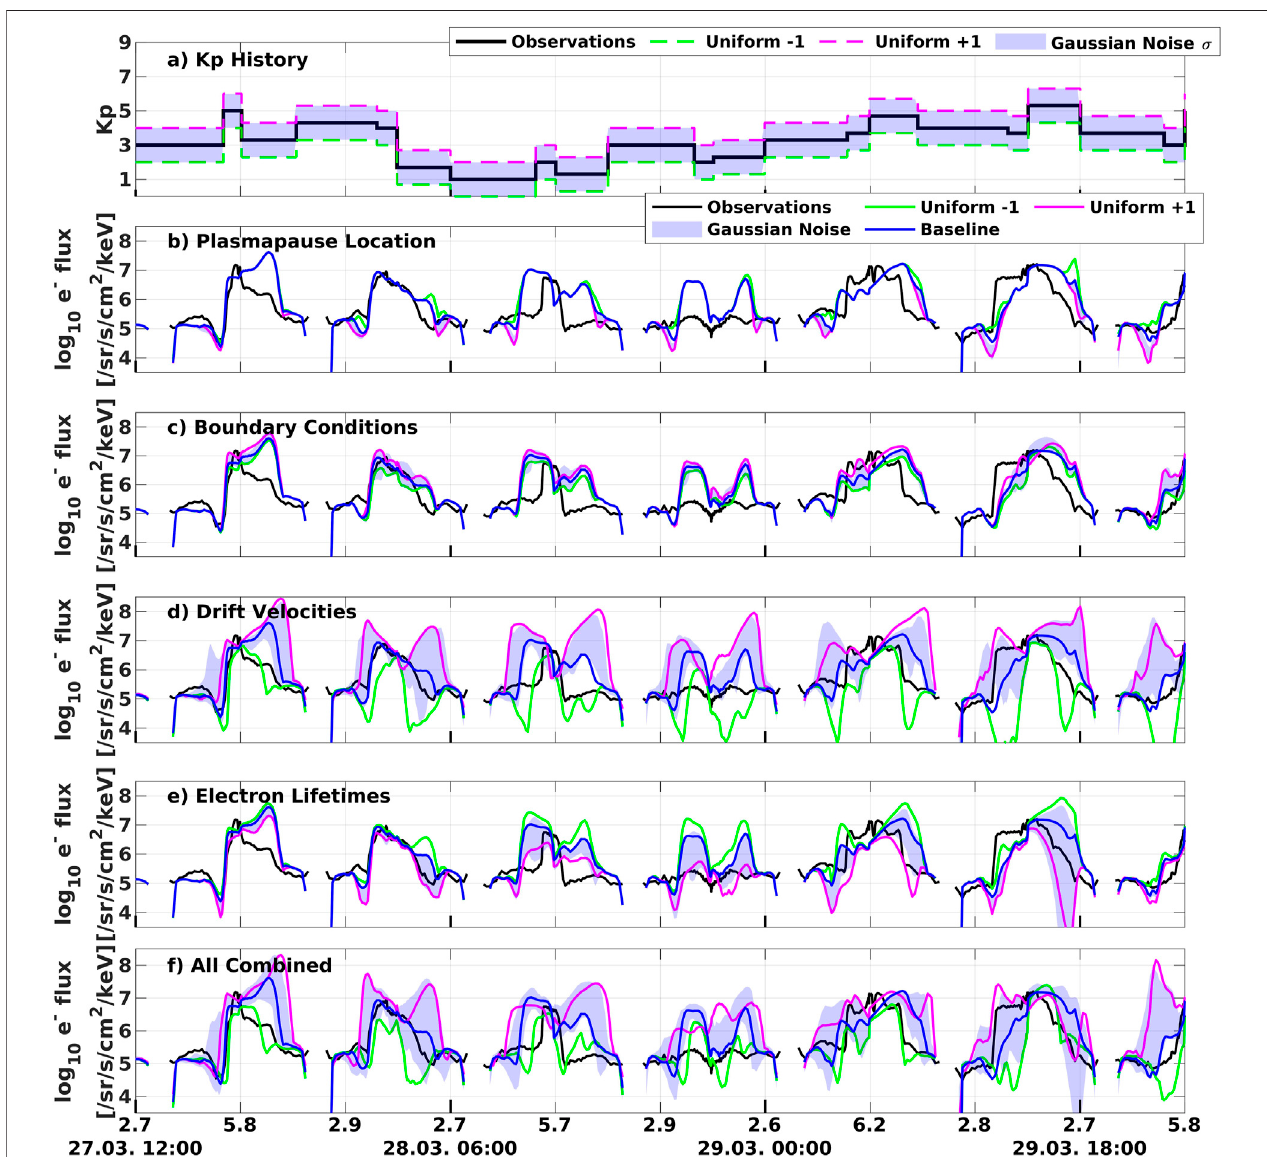
FIGURE 3 | Perturbation results of 10 keV electron fl ux and 54 ° local pitch-angle at the spacecraft ’ s location for the moderate event along the RBSP-B orbit. The blue areas show the range of simulation results, when Kp is perturbed using Gaussian noise. The black line in panels b – g shows the RBSP-B fl ux data. (A) Original Kp historyandperturbedones. (B) Perturbingplasmapauselocationmodel. (C) Perturbingboundaryconditionmodel. (D) Perturbingdriftvelocities. (E) Perturbingelectron lifetime models. (F) Perturbing all processes